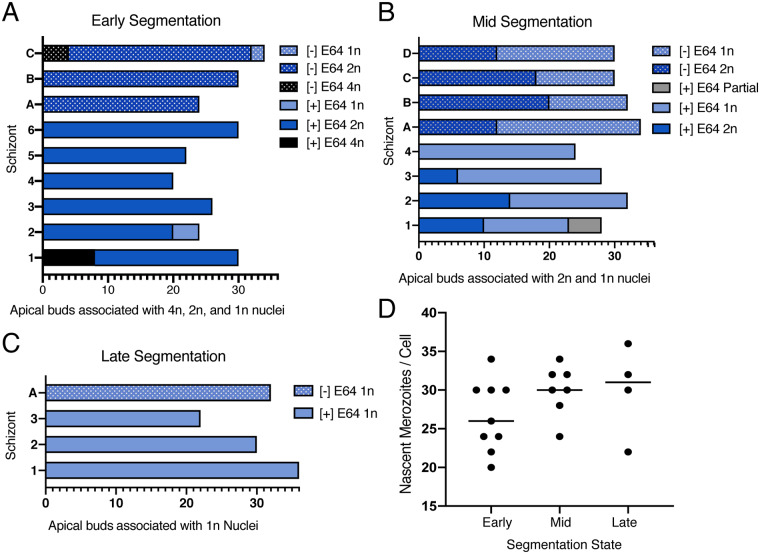
Nuclear status of parasites at early, mid, and late segmentation.A. Graph demonstrating the number of apical buds associated with 4n, 2n, and 1n nuclei in three schizonts from an E64-untreated block and six schizonts from an E64 treated block. B. Graph demonstrating the number of apical buds associated with 2n and 1n nuclei in four schizonts from a [–]E64 (A-D) and four schizonts from a [+]E64 (1–4) treated sample. C. Graph depicting the number of apical buds associated with 1n nuclei in one [–]E64 treated schizont and three [+]E64 treated schizonts. D. Plot of the number of nascent merozoites per fully captured cell. Line placed at median for each set.